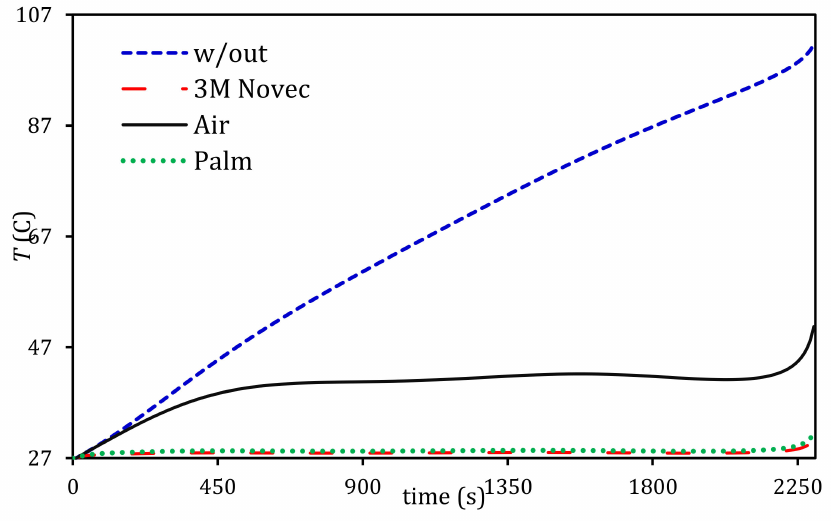
Figure 16. LIB module temperatures versus time using different cooling strategies at a 3C discharge